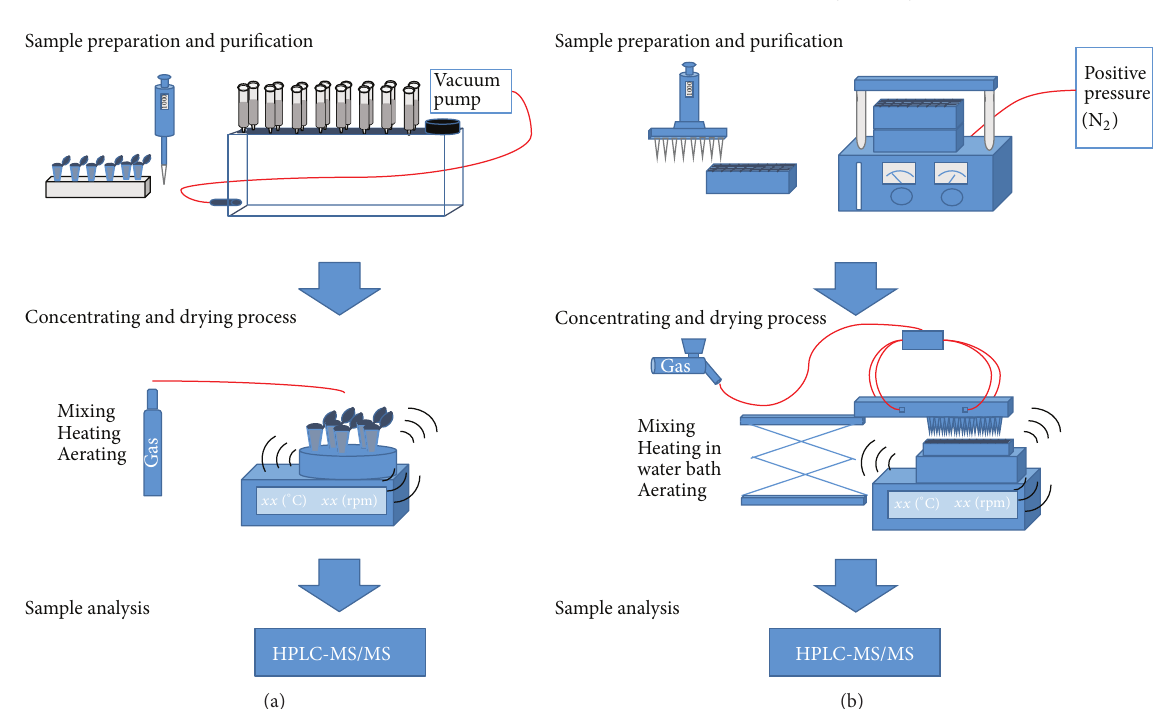
Figure 1: Scale-up process and optimization steps to establish a high-throughput approach of all bioanalytical assays utilizing solid-phase extraction. On the left side the development approach of sample preparation and purification is illustrated (a). The solid-phase extraction is performed by cartridges using the vacuum manifold. By contrast the scale-up is shown on the right side (b). Samples were prepared in 96-well approaches utilizing multichannel pipettes. The purification is conducted on a positive pressure manifold with 96-well plates. For the drying process the applied thermomixer was modified by a heatable water bath and a special drying top frame to deal with the deep-well collection plates (in-house